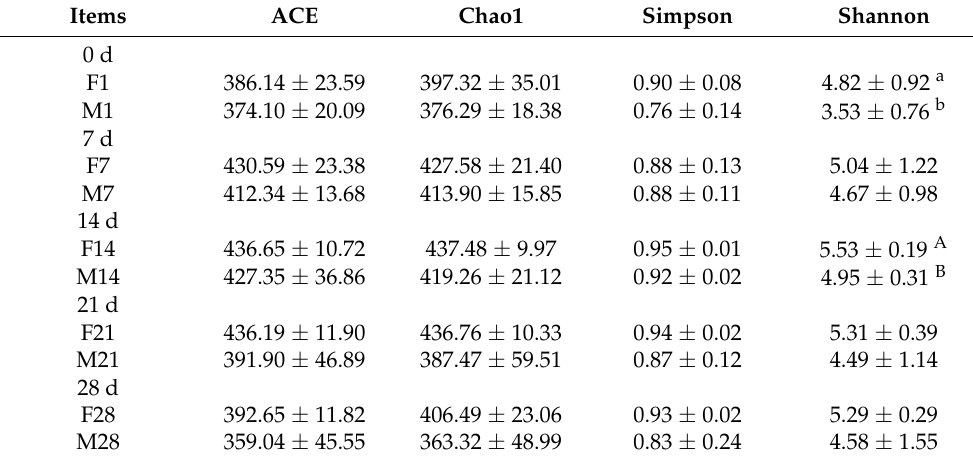
Table 6. Effects of different protein sources on the Alpha diversity of feces of weaned blue foxes.